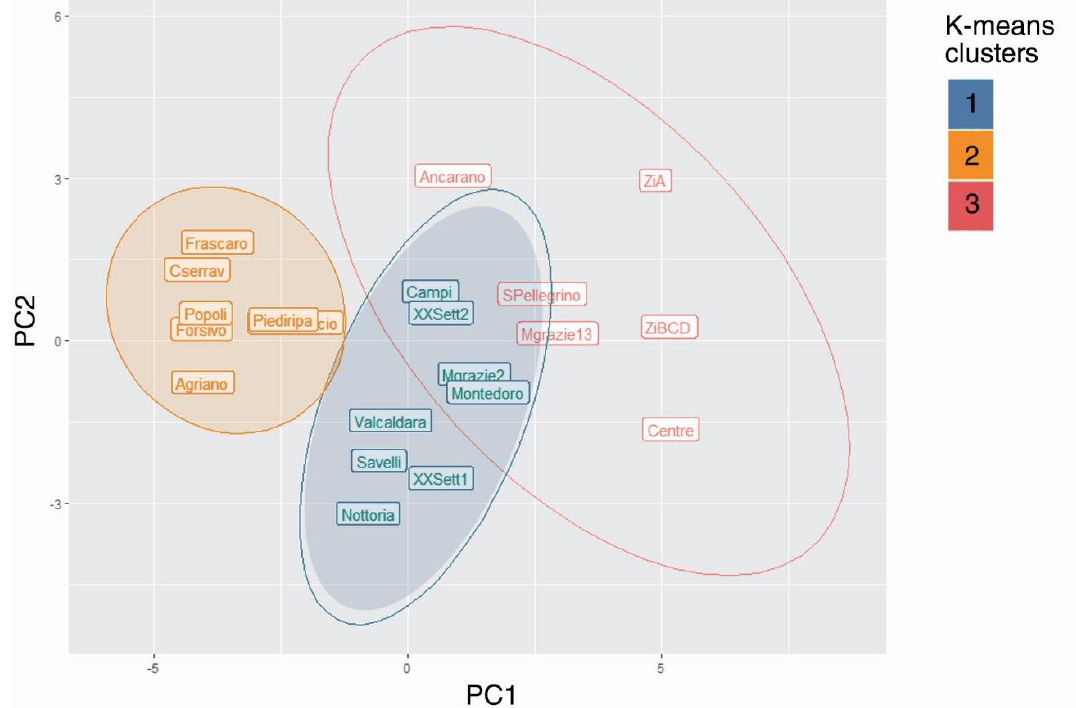
Figure 13 K-means analysis (K=3), VGA indices and city centre.